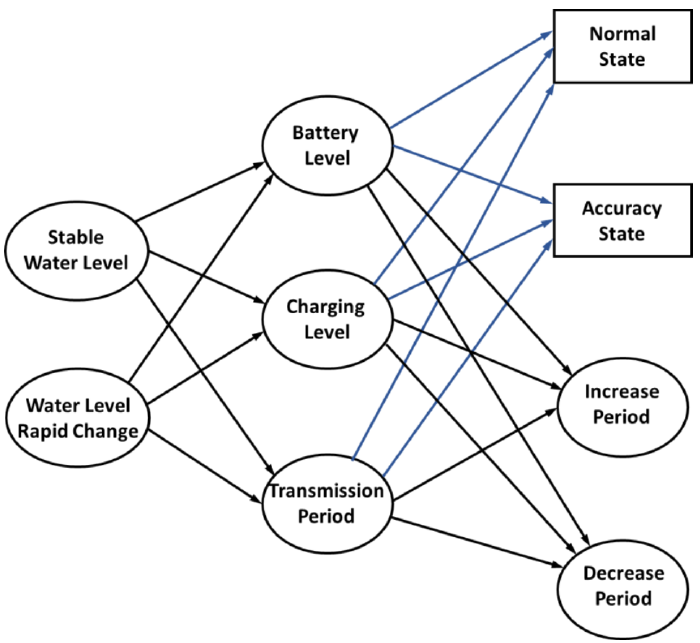
Figure 3. Decision making diagram of the proposed power self-optimizing process. To reduce flood damage and flexibly regulate the retarding basin, water level moni- toring is an important application in a smart city sensor network. For these applications, the change of water level will be considered first in the proposed process. The change of water level is divided into two states or levels, the stable state and the rapid changing state. A previous study in [27] proposed a deviation for the actual estimated distance, wherein the deviation was less than 1% in the experiment. Thus, the difference of the current estimated water level and the last estimated water level over 1% implies that the water level is changing quickly. Otherwise, when the change is less than 1%, it implies that the water level is stable. Battery level, device charging level, and data transmission period are considered as power conditions in the device. With these power conditions, the device lifetime can be estimated. For example, the device transforms to a normal state and increases its transmission period to save on power consumption when the battery level and the charging level are low and the water level is stable. The power conditions of the device determine which state and which action is better. The main rule for improving power efficiency is that charging efficiency must be greater or equal to the total power consumption of the device, as shown in Equation (2). Equation (2) aims to keep the system current larger or equal to the charging current, which is used to maintain or charge the battery power. It is used to determine whether using multi-step measurement is possible or not, and to enable solar charging to cover the additional motor power consumption needed to avoid decreasing the device